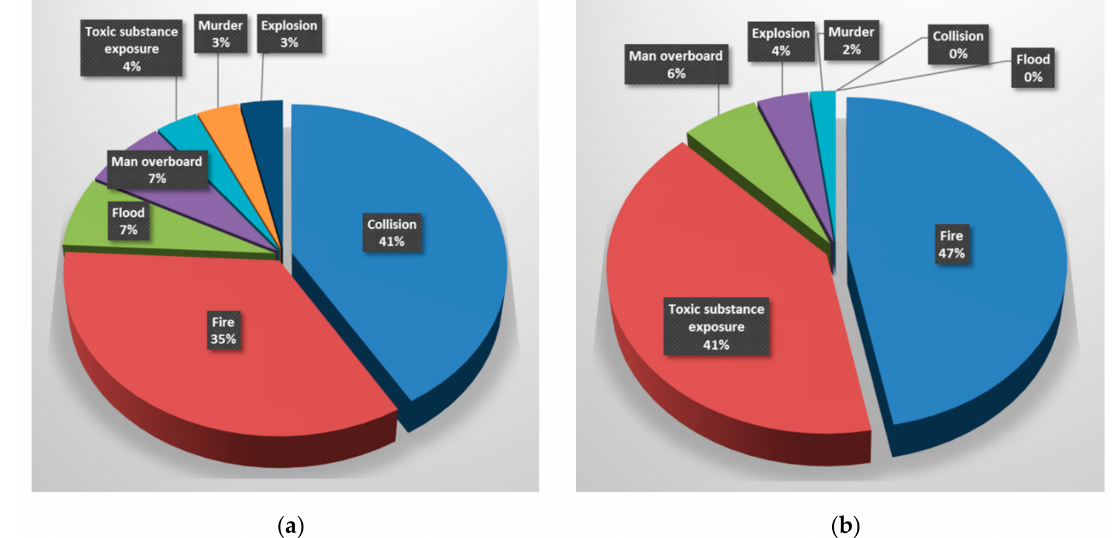
Figure 2. ( a ) Relative Contribution of Submarine Incident Types, 2006–2015 ( b ) Submarine Fatalities by Incident Type, 2006–2015.